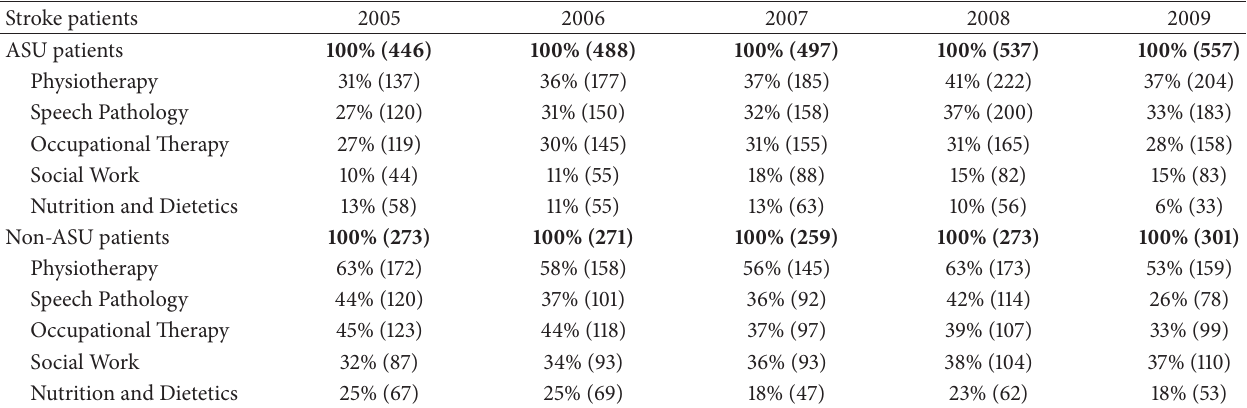
Table 1: Percentage (number) of patients with stroke that received healthcare from Physiotherapy, Speech Pathology, Occupational Therapy, Social Work, and Nutrition and Dietetic per year: ASU versus non-ASU.